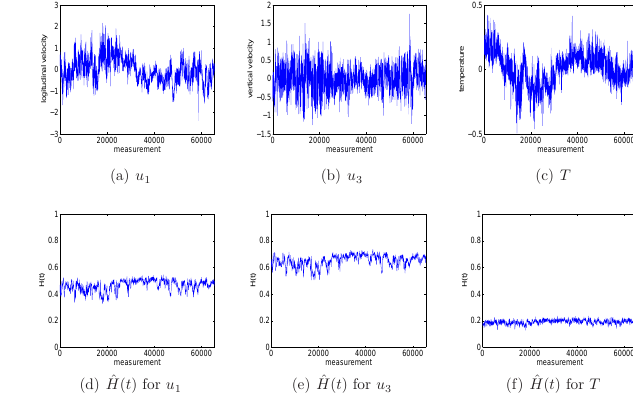
Figure 5: Two velocity ((a) longitudinal u 1 and (b) vertical u 3 ) and (c) tempera- Fig. 5. Two velocity ( a longitudinal u 1 and b vertical u 3 ) and (c) ture T signals under stable conditions from the 12th run are shown in the upper temperature T signals under stable conditions from the 12th run row. The corresponding estimated H ( t ) are shown in the lower row. are shown in the upper row. The corresponding estimated H(t) are shown in the lower row.